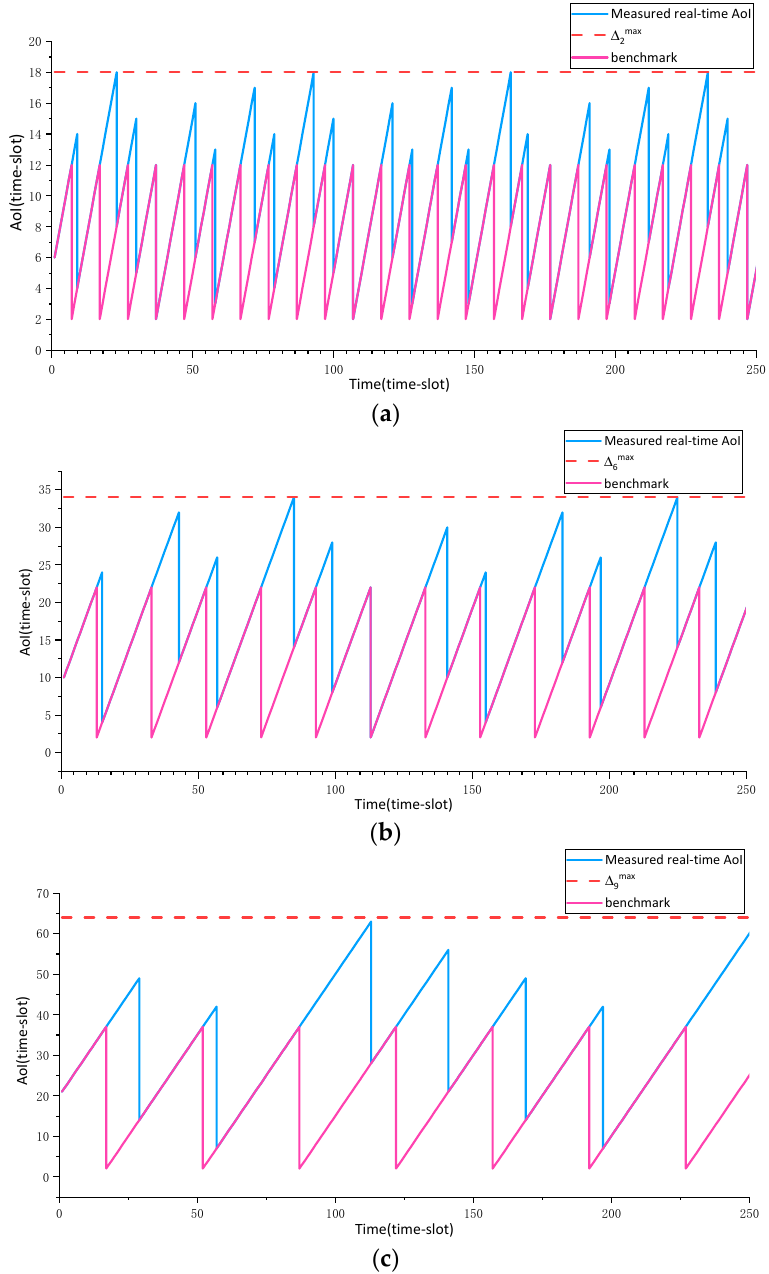
Figure 4. The real-time AoI, with the corresponding peak AoI and benchmark of three sample nodes: ( a ) node #2, ( b ) node #6, ( c ) node #9.